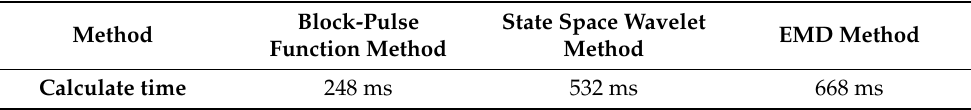
Table 4. Calculating time in the three methods used in the same three-degree-of-freedom system.